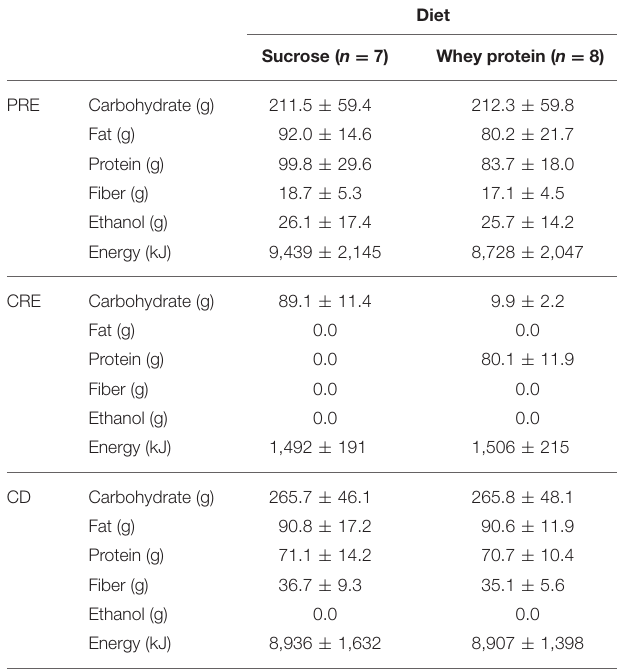
TABLE 2 | Composition of the diets during the three different phases of this